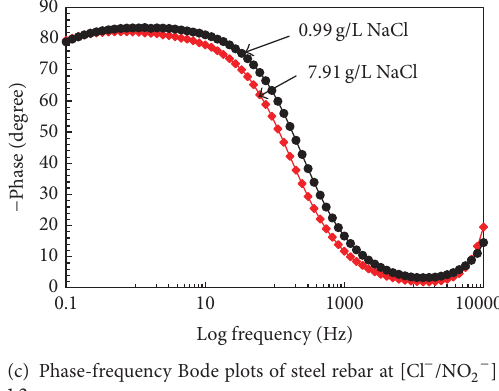
(a) Nyquist plots of steel rebar at [Cl − / NO 2− ] = 1.2 (b) Impedance-frequency Bode plots of steel rebar at [Cl − / NO 2− ] = 1.2